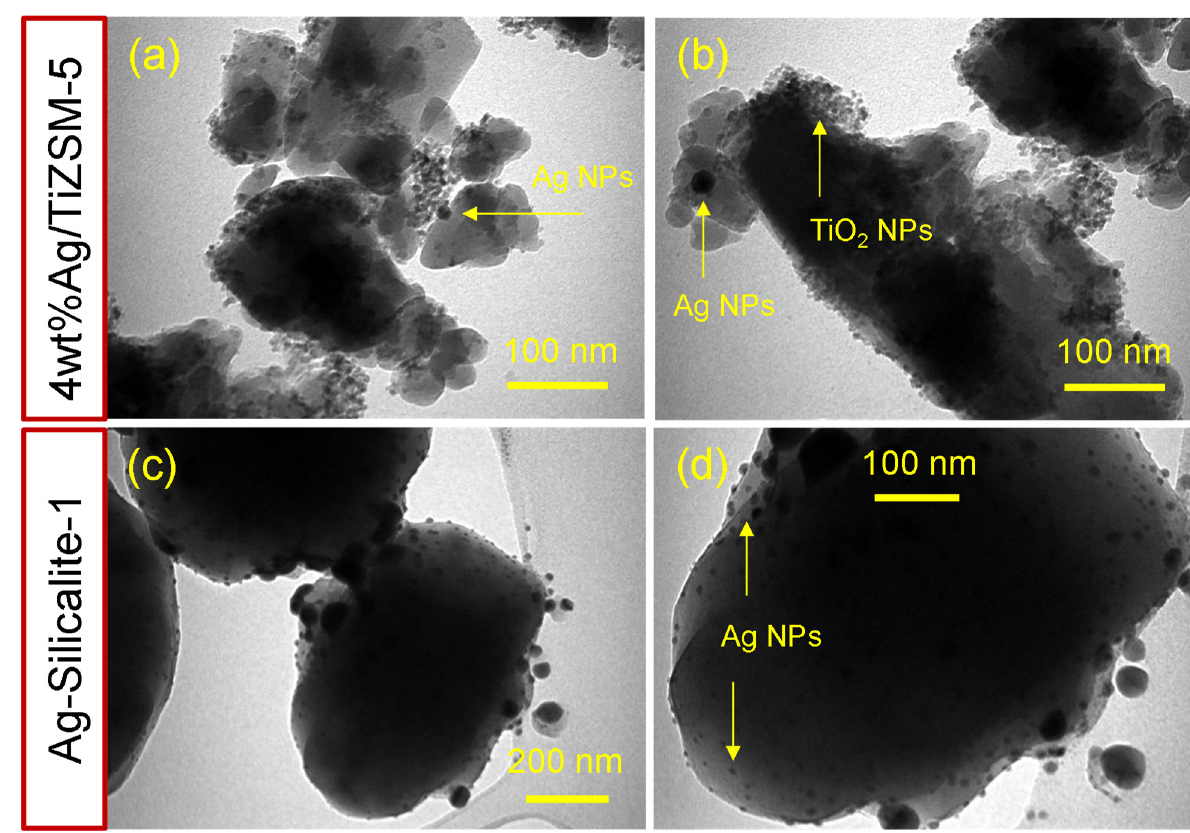
Figure 8. TEM images of Ag impregnated TiZSM-5 ( a , b ) 4 wt%Ag/TiZSM-5 and ( c , d ) Ag-silicalite-1.